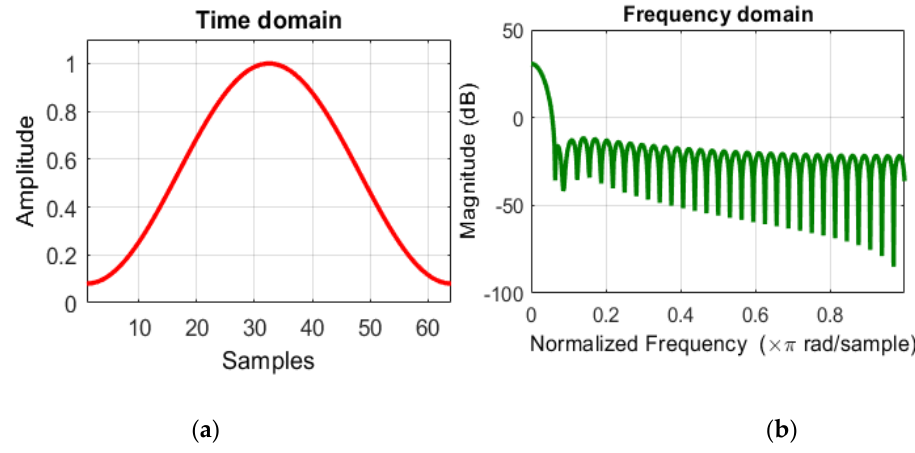
Figure 9. Hamming window in ( a ) the time domain and ( b ) the frequency domain, representing a length of 64 in the time domain.